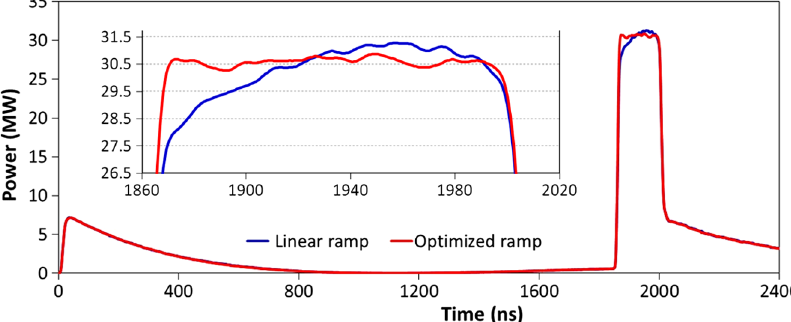
FIG. 15. Comparison of measured output pulse shape at XBOX-3 for a linear phase ramp and an optimized phase; inset shows compressed pulse